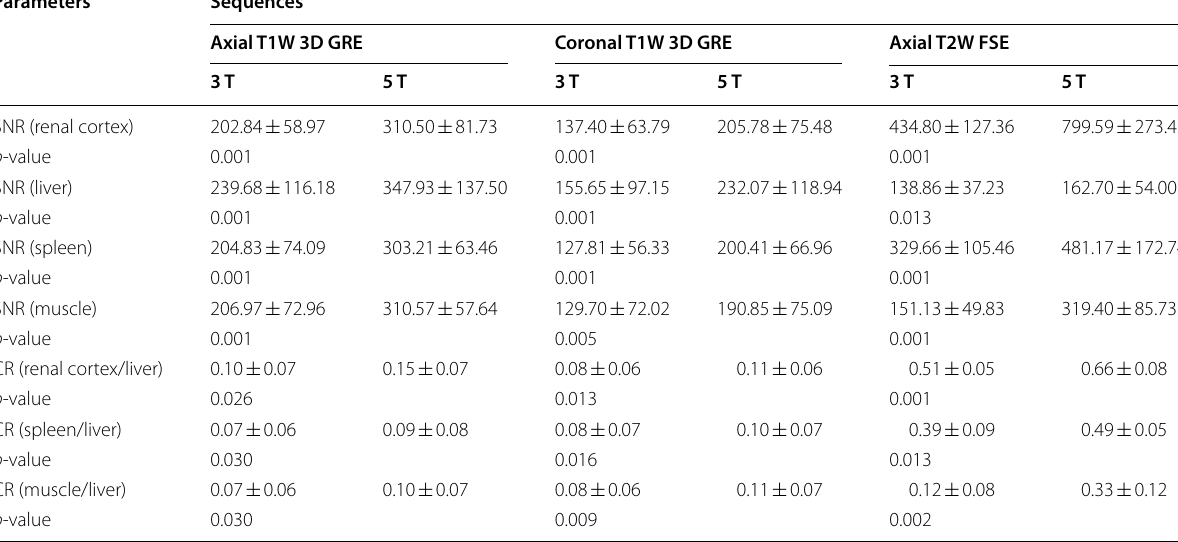
SNRs and CRs are given as mean